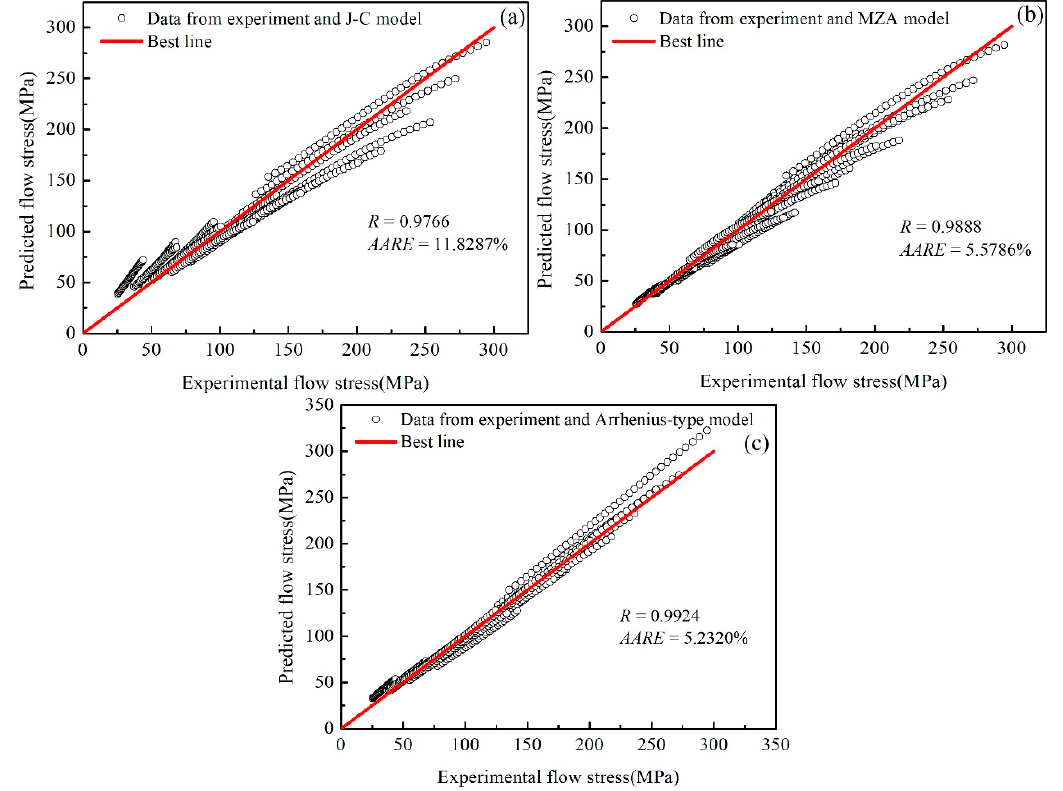
Figure 18. Comparison between experimental results and predicted results from ( a ) the J–C model, ( b ) the modified Z–A model, and ( c ) the A-type model for different strain rates and